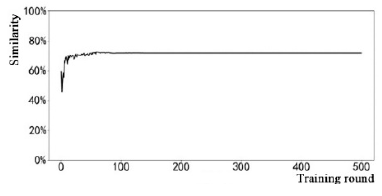
Figure 29. Full expert-driven learning.